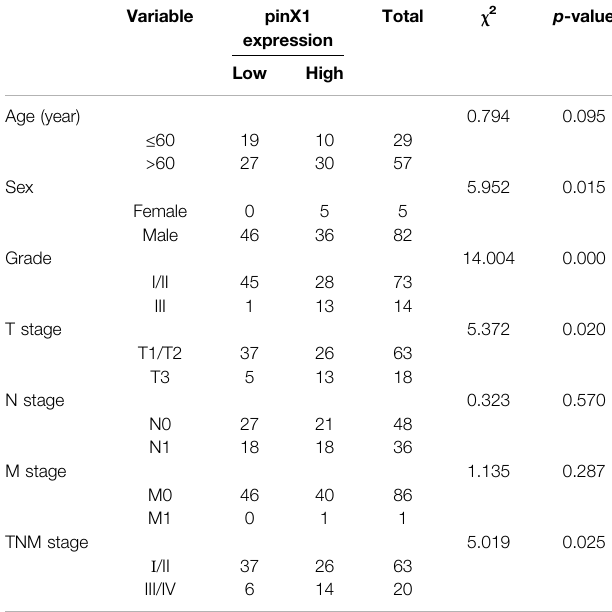
TABLE 1 | Differential expression of pinX1 in lung cancer and adjacent tissues. n pinX1 expression